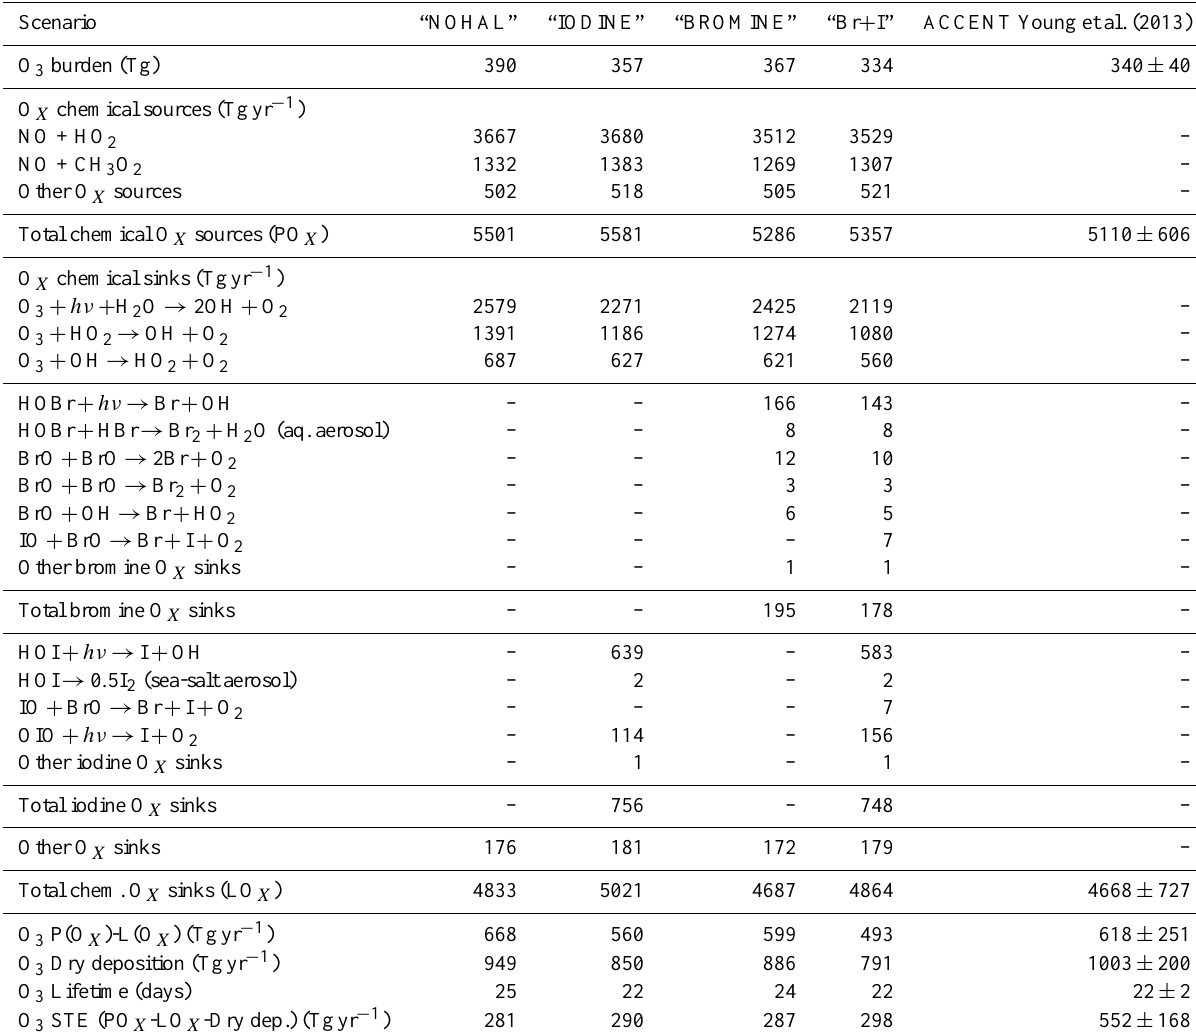
Table 7. Comparison between global tropospheric O X budgets of simulations “BROMINE”, “Br + I”, “IODINE”, and “NOHAL” are de- scribed here. “BROMINE” includes just bromine chemistry, “Br + I” includes both iodine and bromine chemistry, “IODINE” only includes iodine chemistry, and “NOHAL” is simulation without iodine or bromine chemistry. Recent average model values from Young et al. (2013) are also shown. For the IO + BrO halogen crossover reaction we allocate half the O 3 loss to bromine and half to iodine. Values are rounded to the nearest integer